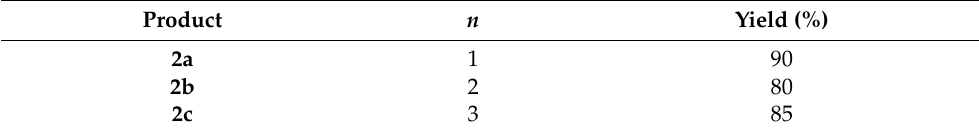
Table 1. Yields of 4-aminoalkylquinolin-2-ones 2 , prepared according to Scheme 1. Product